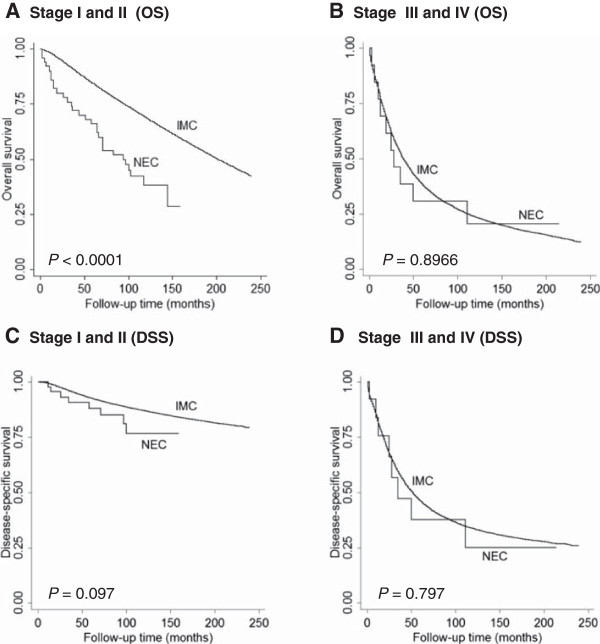
Overall survival (OS) and disease-specific survival (DSS) comparisons between neuroendocrine carcinoma (NEC) and invasive mammary carcinoma, not otherwise specified (IMC) diagnosed between 1998 and 2002. Although OS was significantly shorter in NEC than in IMC-NOS in early stage disease (A), there was no difference in DSS between NEC and IMC-NOS (C). There was no difference in both OS and DSS between NEC and IMC-NOS in advanced stage disease (B and D).